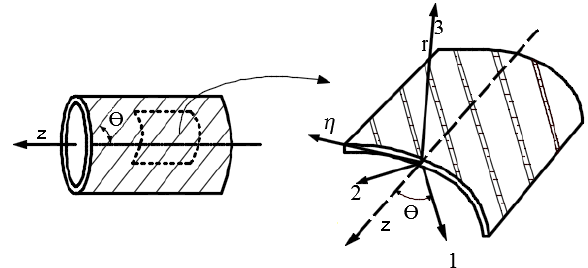
Figure 2. Relationship between the material principal direction 1 and the Z axis of boring bar coordinate system.